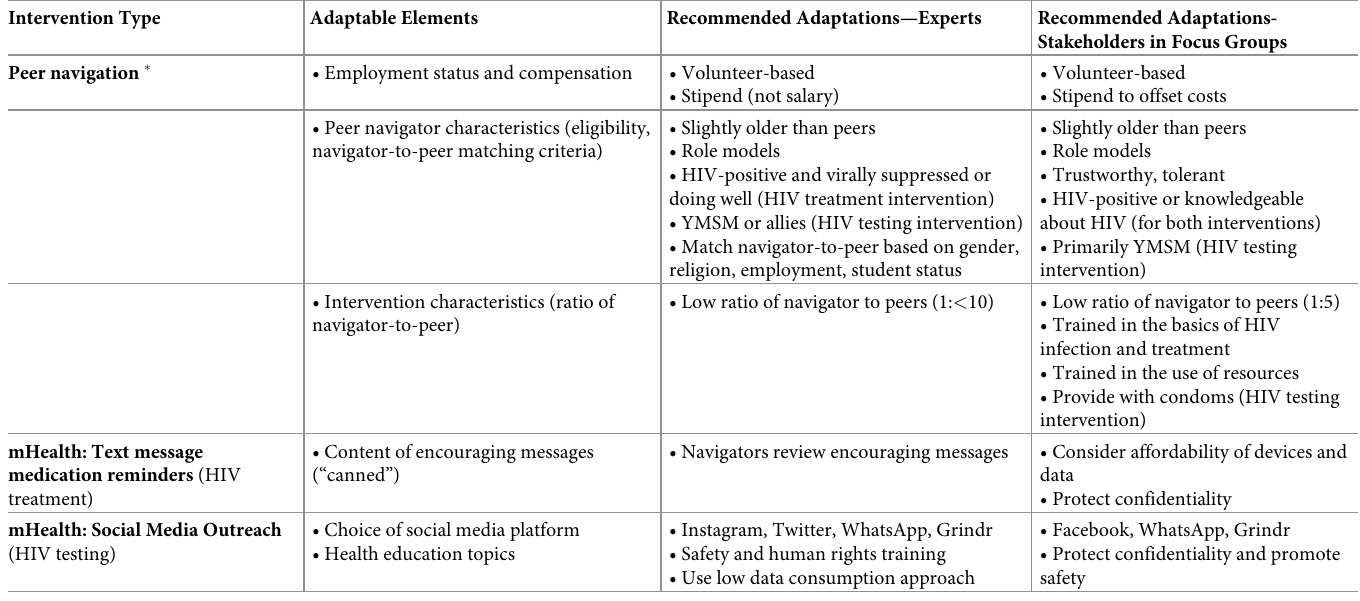
Table 2. Core and adaptable intervention elements with expert and stakeholder recommendations, iCARE